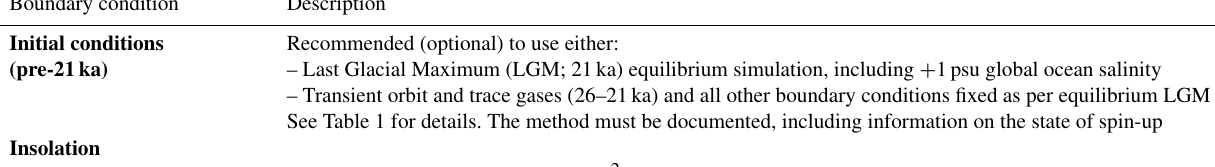
Table 2. Summary of required model boundary conditions for the last deglaciation Core experiment 21–9ka version 1; optional boundary conditions are labelled as such. Data are available from PMIP4 last deglaciation wiki (PMIP Last Deglaciation Working Group, 2016). See text for details. Boundary condition group headings are in